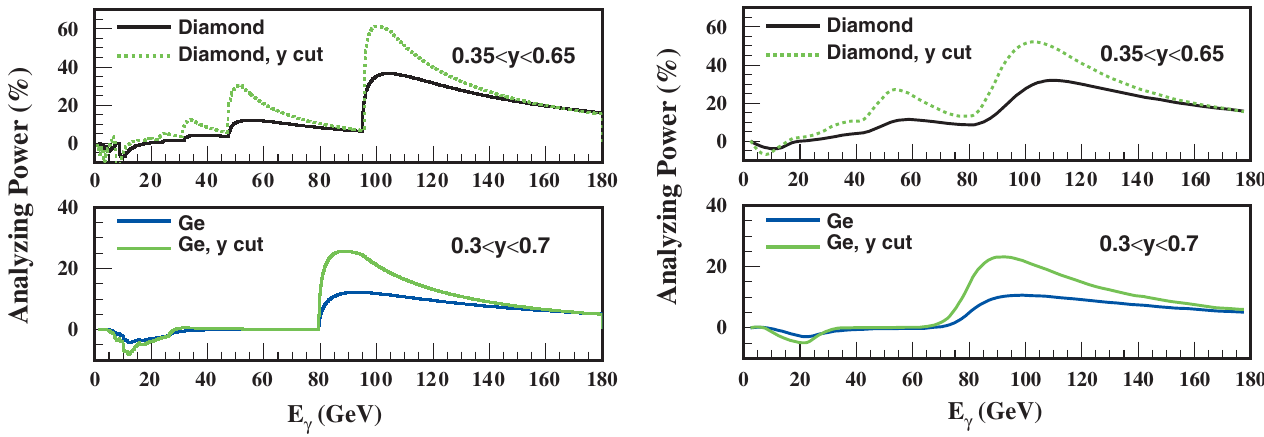
FIG. 5. (Color) Analyzing power of different single crystals, for an ideal e (cid:1) beam without any angular divergences (left) and for the actual e (cid:1) beam conditions